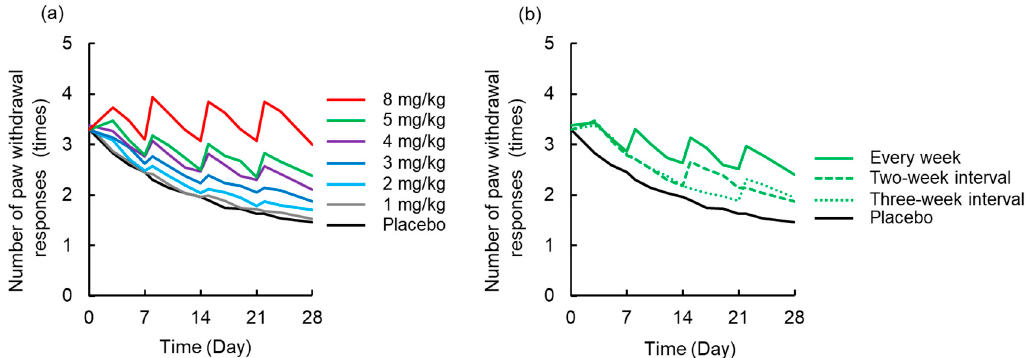
Figure 6. Simulated time-course profile obtained using the pharmacokinetic-toxicodynamic (PK-TD) model for the number of paw withdrawal responses in the acetone test. ( a ) Simulated data after administration of placebo or L-OHP (1–8 mg/kg) once per week for four weeks, ( b ) L-OHP (5 mg/kg) every week, with two-week interval (Day 0 and 14), and three-week interval (Day 0 and 21). PK-TD parameters: V = 357.8 mL·kg − 1 , k e = 3.4 h − 1 , k 12 = 2.6 h − 1 , k 21 = 1.1 h − 1 , k in,acute = 0.004 day − 1 , k out,acute = 0.06 day − 1 , k handling = 0.08 day − 1 , E max,acute = 10.1, EC 50, acute = 0.36 μ g ‧ mL − 1 , γ acute = 6.